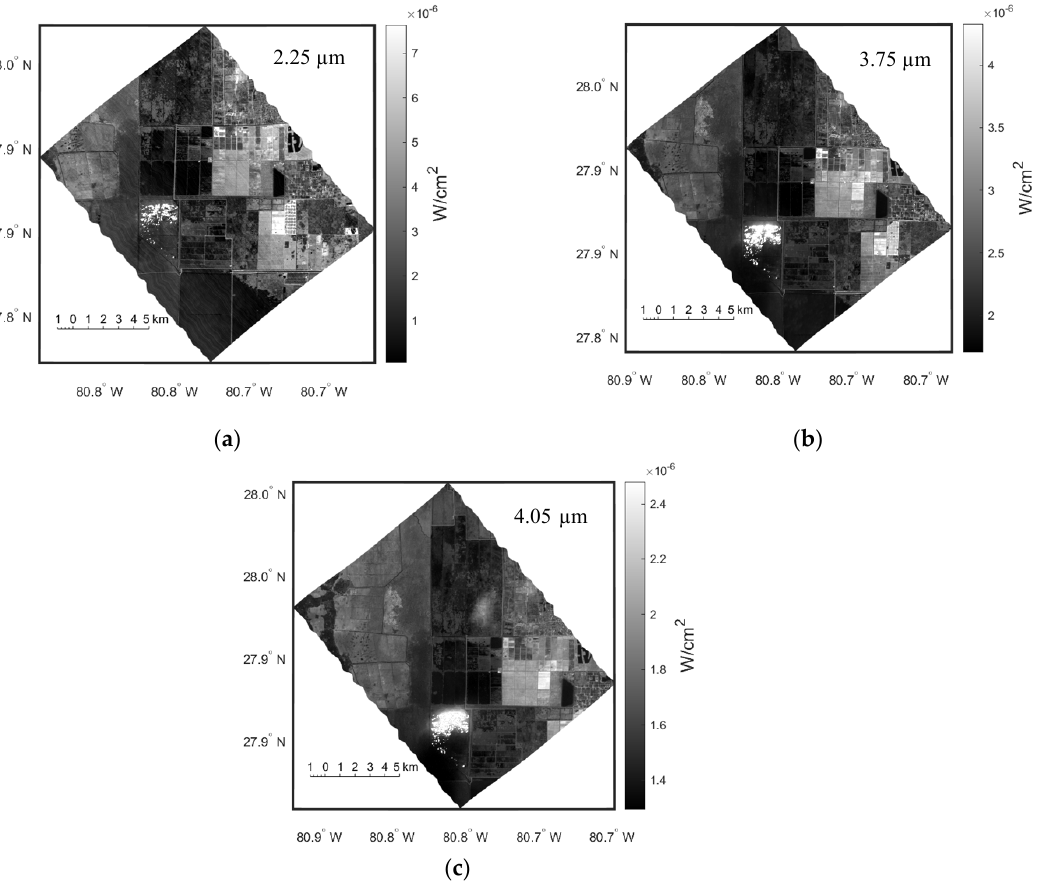
Figure 7. Calibrated, geo-registered irradiance of a controlled agricultural burn at 27.857° N, 80.756° W for Case M over Florida during Science Flight #2 on 19 January 2021. The figure present images from the ( a ) 2.25 μ m, ( b ) 3.75 μ m (nadir), and ( c ) 4.05 μ m channels, respectively. The direction of flight was toward the southeast.